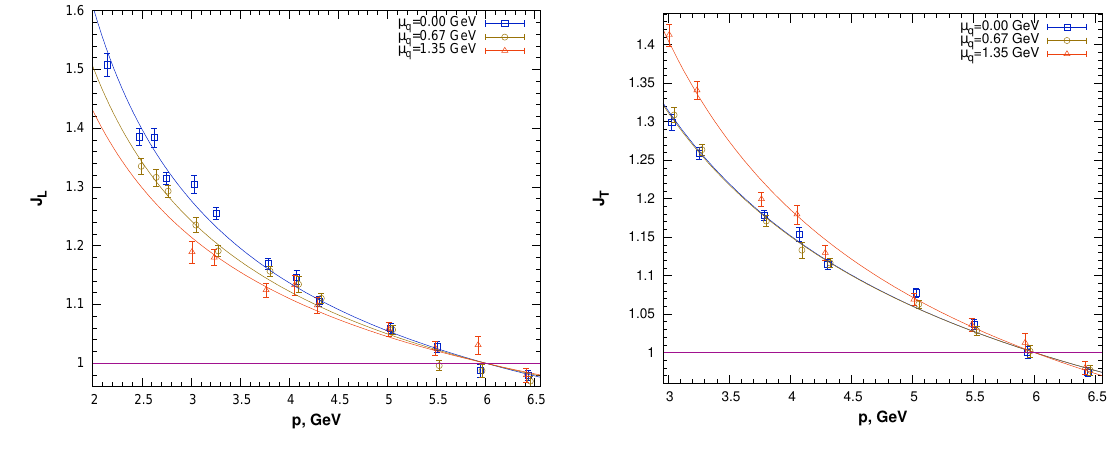
Figure 4. Longitudinal (left panel) and transverse (right panel) dressing functions at various values of µ q . Curves are obtained with the fit function